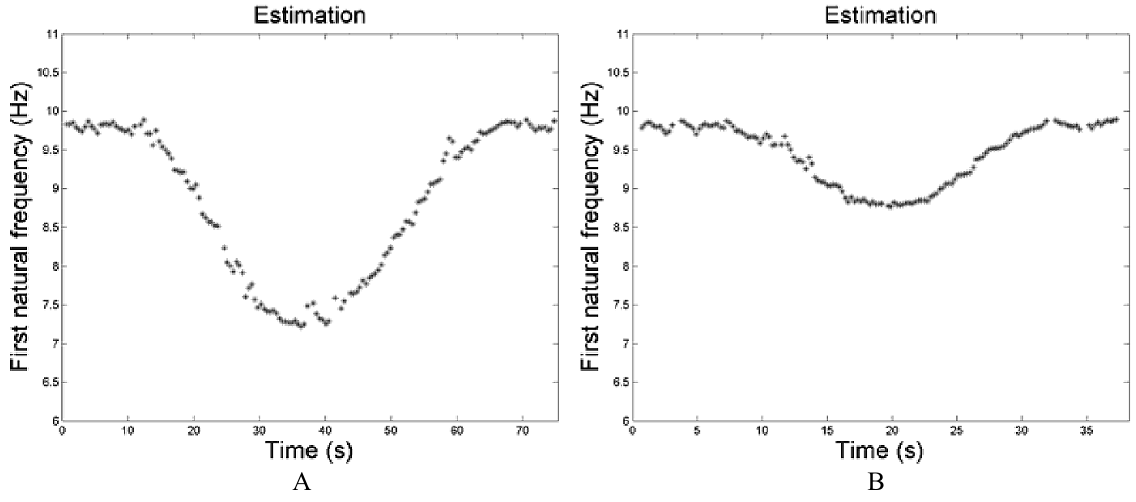
Fig. 4. Estimation of the first natural frequency. A: mass m 1 . B: mass m 2 .